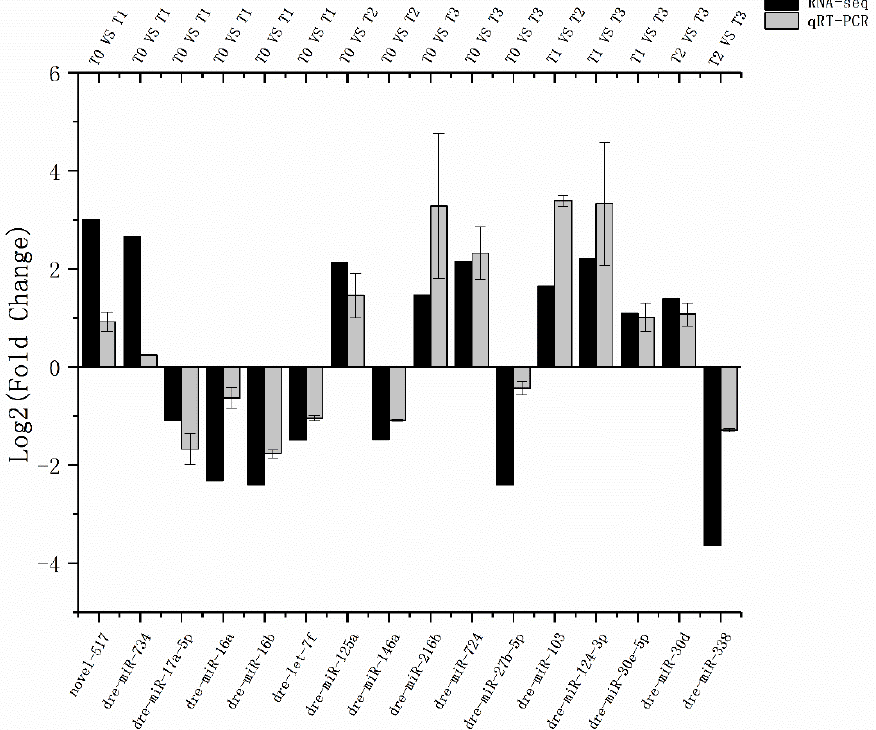
Figure 2. Differently expressed miRNAs validated by qRT-PCR. Comparison was carried out between sRNA-Seq results and qRT-PCR validation results. The 16 selected miRNAs showed concordant expression patterns when the 2 different methods were used.